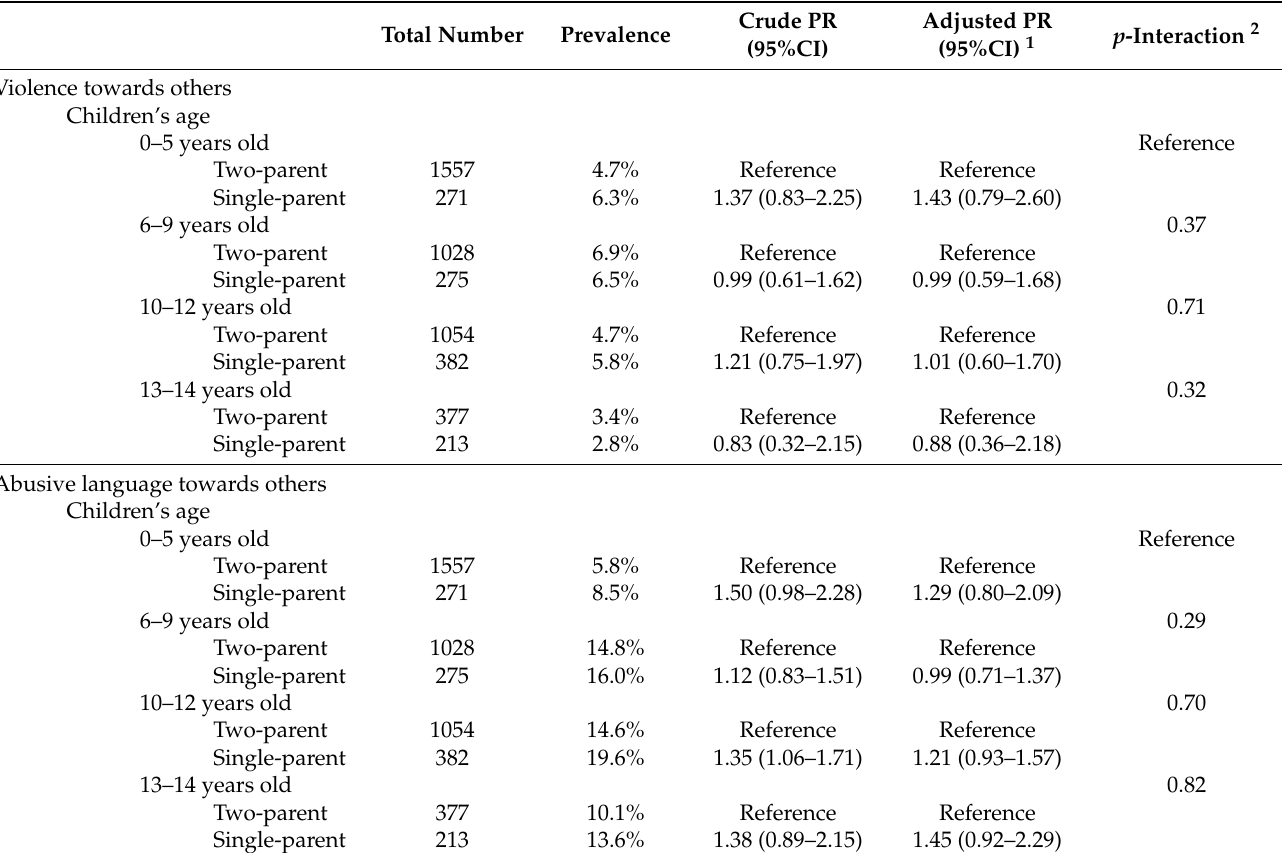
Table A3. Family type and misbehaviors: stratified by children’s age ( n =